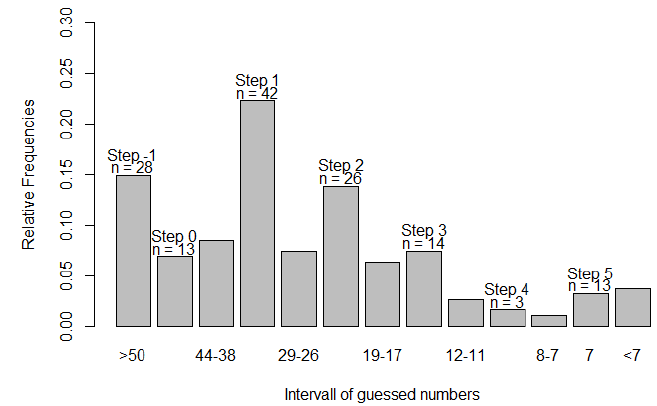
Figure 2. Relative and absolute frequencies of choices according to the interval classification. Depicting steps of reasoning, intervals, and interim intervals.